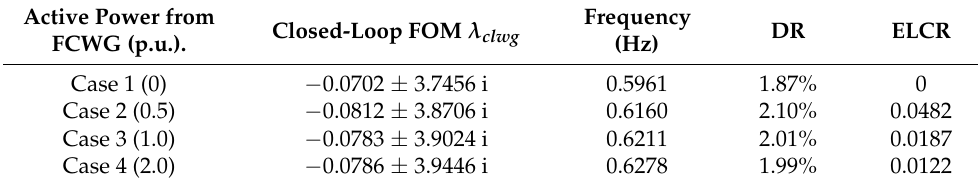
Figure 8. Participation factor analysis for closed-loop EOM2 (0.65 Hz~0.67 Hz). ( a ) Case 1; ( b ) Case 2; ( c ) Case 3; ( d ) Case 4. Table 3. Closed-loop modal analysis of FOM (wind power).